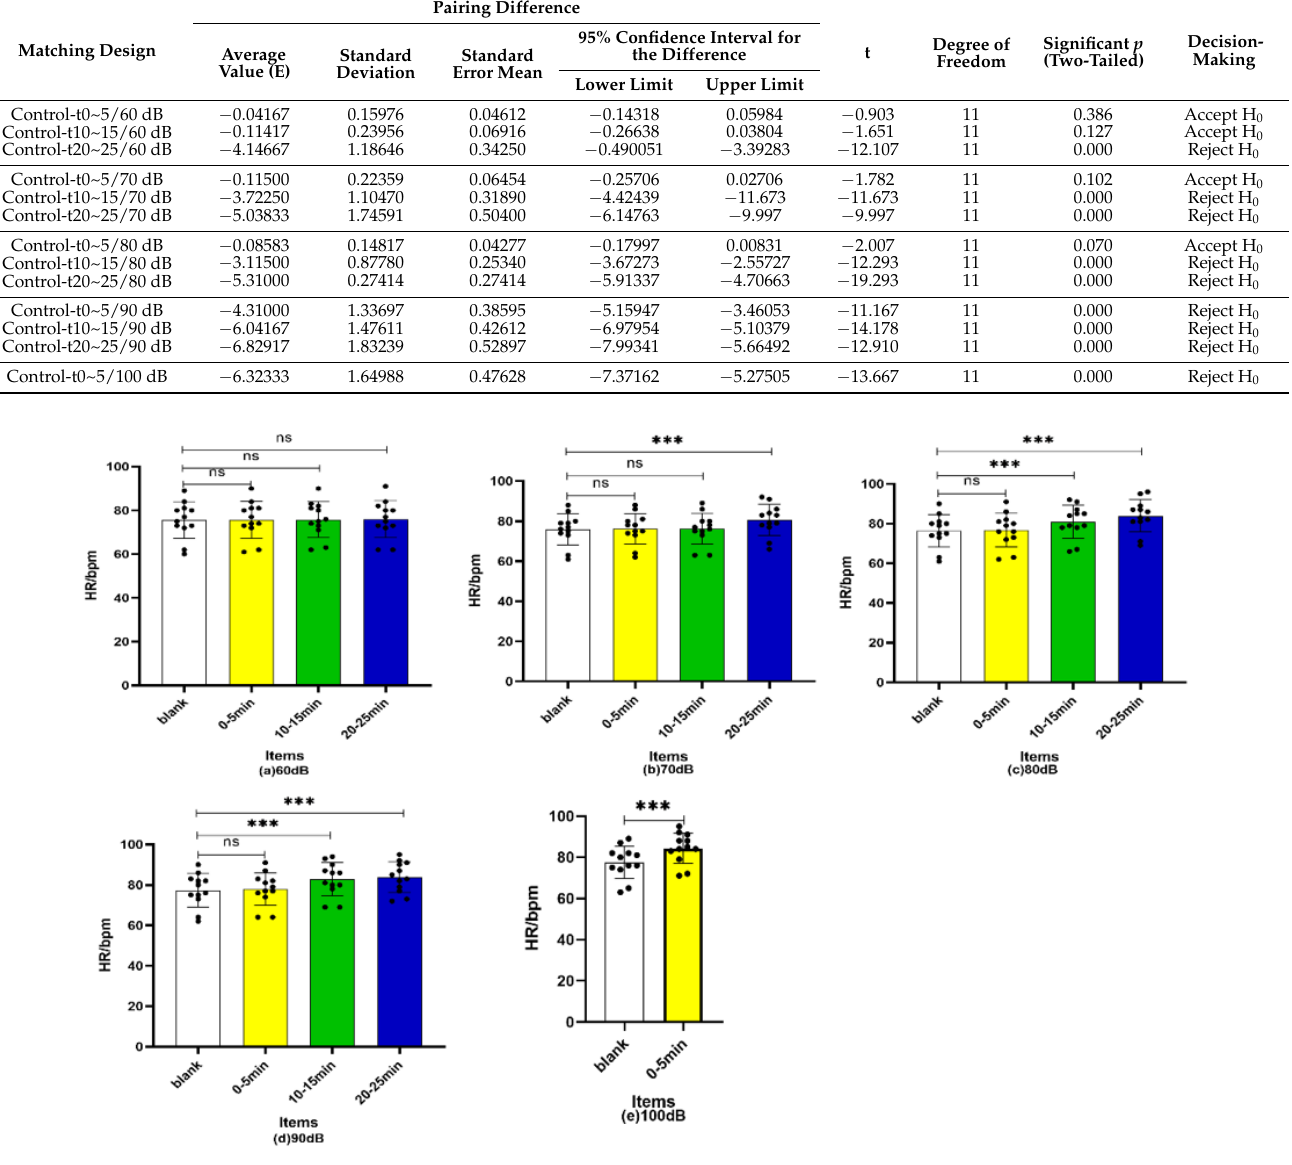
Table 5. Normality test results of heart rate.